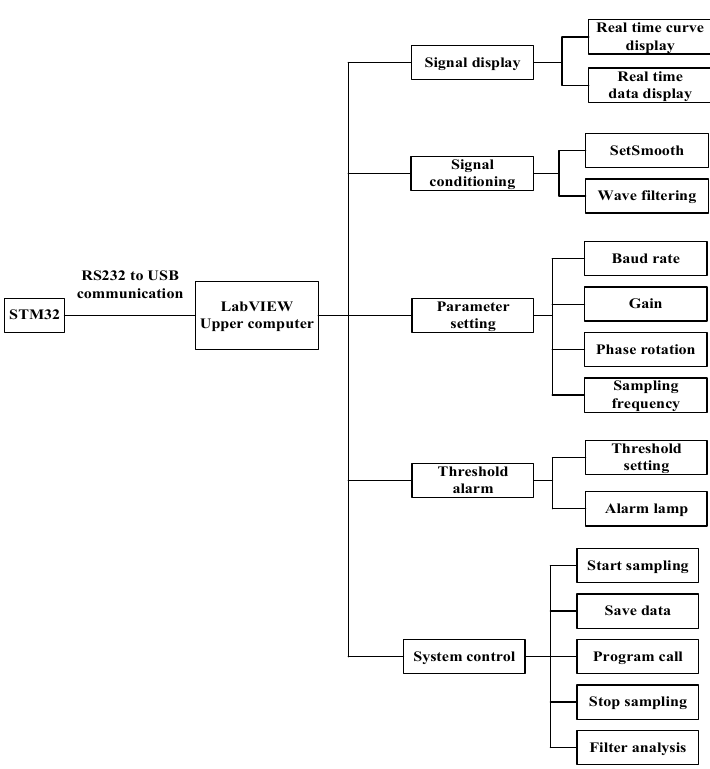
Figure 16. System software overall design structure block diagram.